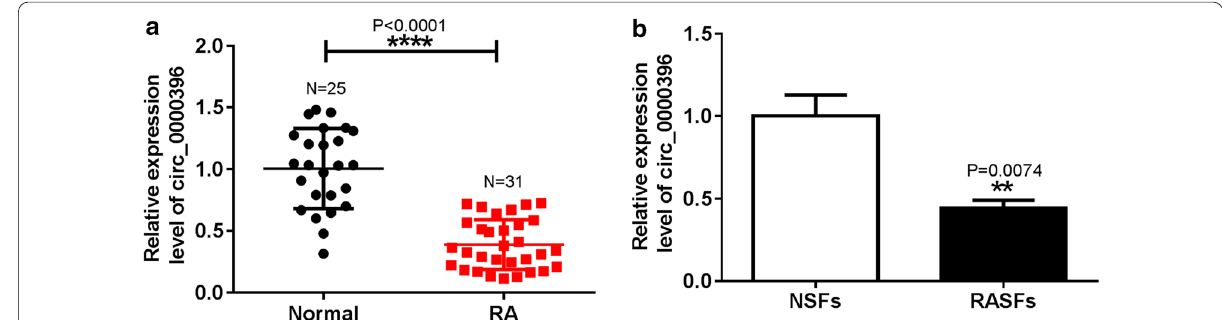
Fig. 1 The expression of circ_0000396 in RA synovial tissues and RASFs. a Expression of circ_0000396 in RA synovial tissues and healthy control tissues was measured by qRT-PCR. b qRT-PCR analysis of circ_0000396 expression in RASFs and NSFs was performed. * p < 0.05, ** p < 0.01, *** p < 0.001, ****